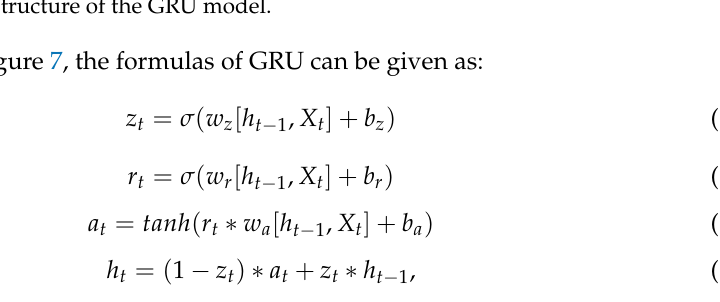
Figure 7. The internal structure of the GRU